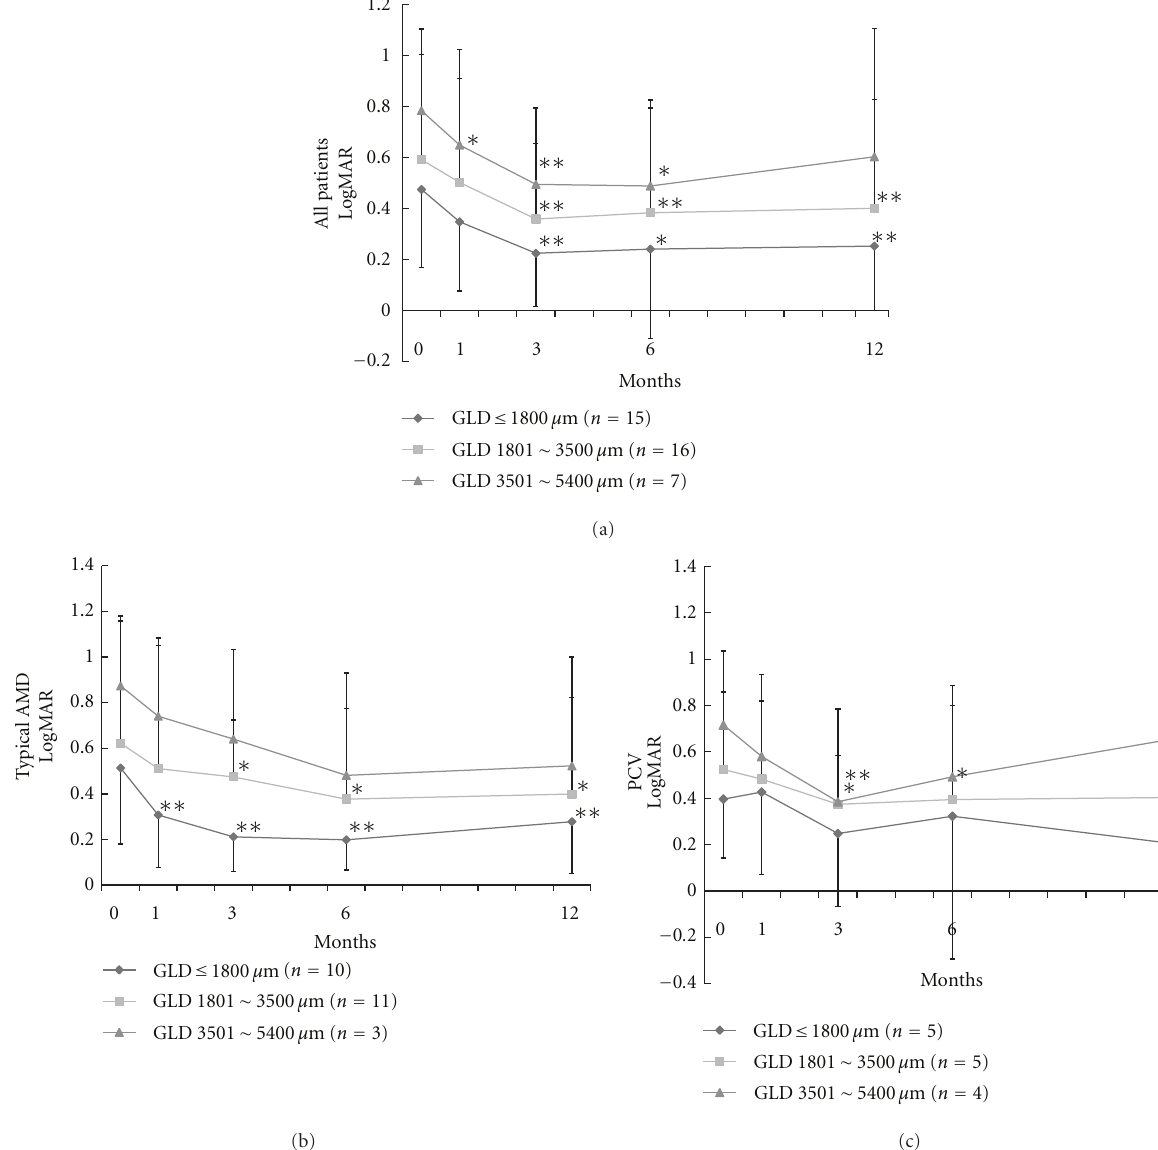
Figure 1: Changes in mean best corrected visual acuity (BCVA). Visual acuity was expressed as the logarithm of minimal angle of resolution (logMAR). (a) Mean BCVA of all 38 patients in three GLD groups; GLD (cid:2) 1800 µ m, GLD between 1801 and 3500 µ m, and GLD between 3501 and 5400 µ m. The group of greatest linear dimension (GLD) (cid:2) 1800 µ m showed better BCVA than those of the other 2 groups at all time points. However, there was no significant di ff erent among the 3 groups ( P > 0 . 05). (b) Mean BCVA of typical AMD of 24 patients in three GLD groups. (c) Mean BCVA of PCV of 14 patients in 3 GLD groups. Bars indicate standard deviations. ∗ P < 0 . 05, ∗∗ P < 0 . 01; P value for comparison between baseline and each visit. AMD: age-related macular degeneration, PCV: polypoidal choroidal vasculopathy.